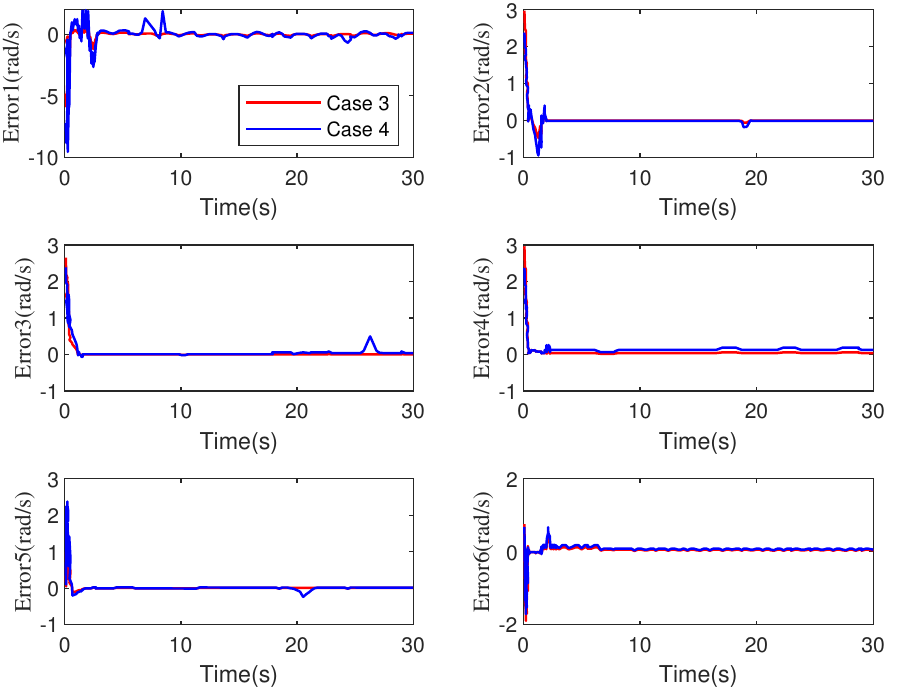
Figure 17. Velocity estimation errors with time-varying external disturbances in Case 3 and Case 4 for the 6-DOF robot manipulator.